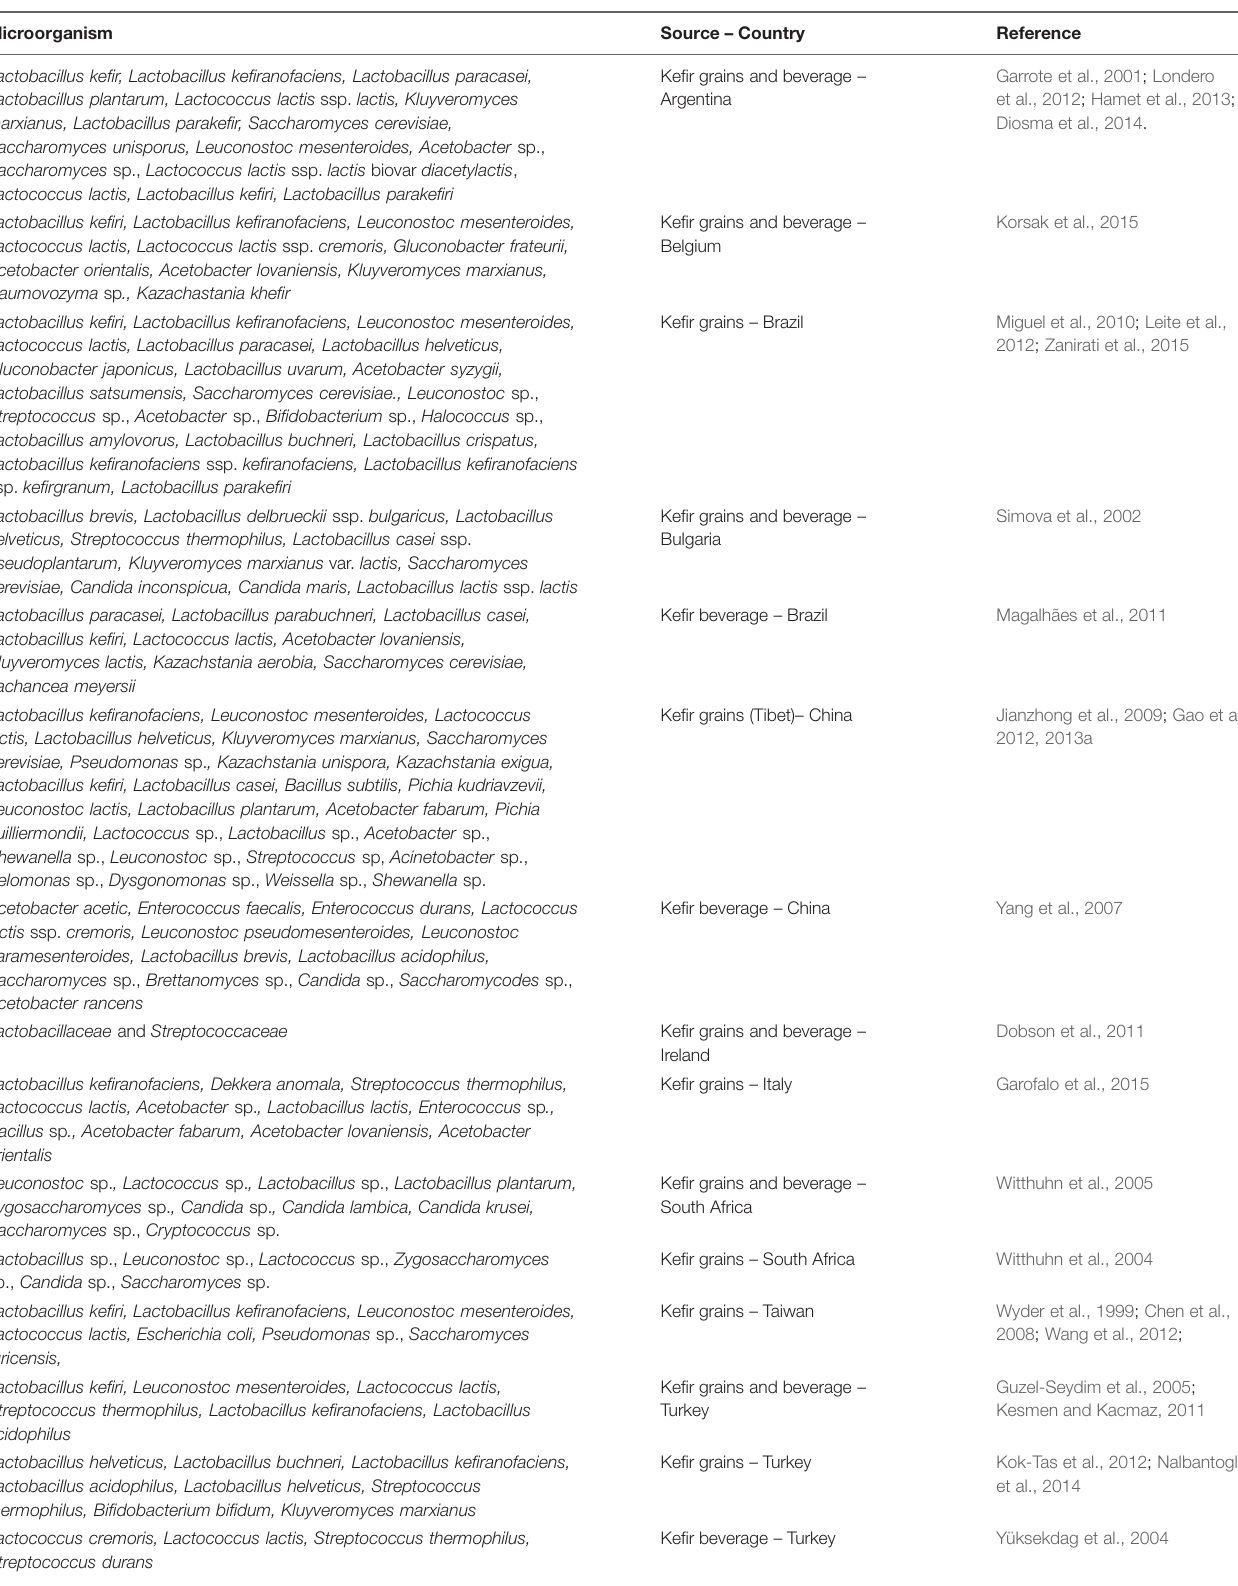
TABLE 1 | Microbial compositions found in kefir and kefir grains of different